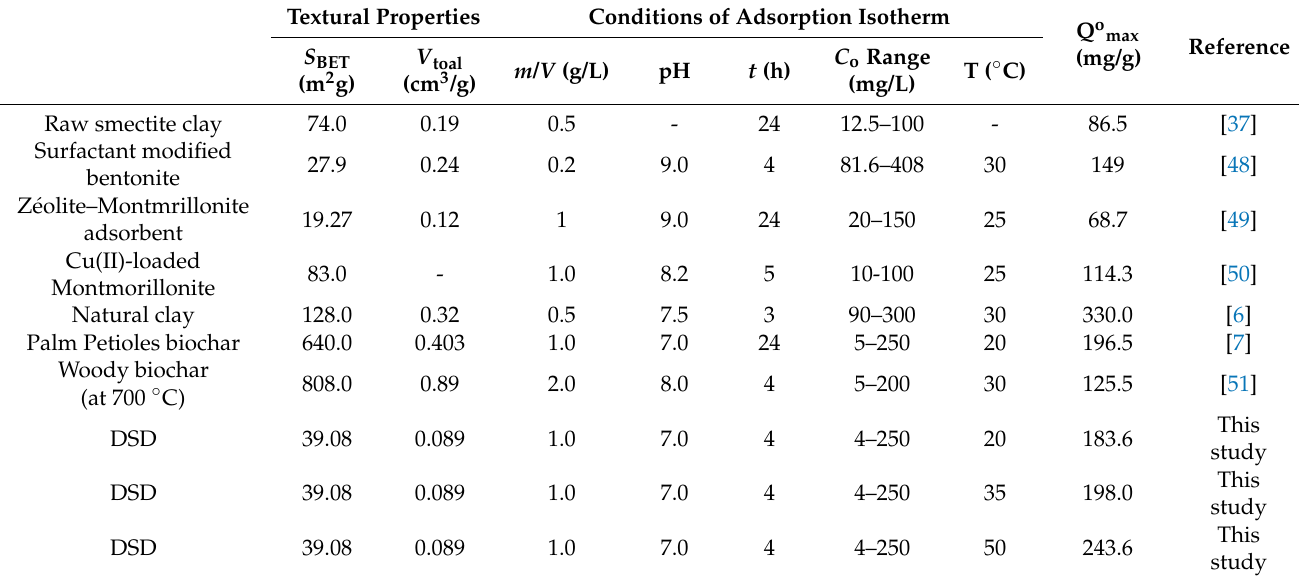
Table 6. Comparison of the monolayer adsorption capacity (Q omax ) of CV Dye onto DSD material to different adsorbents reported in the literature.